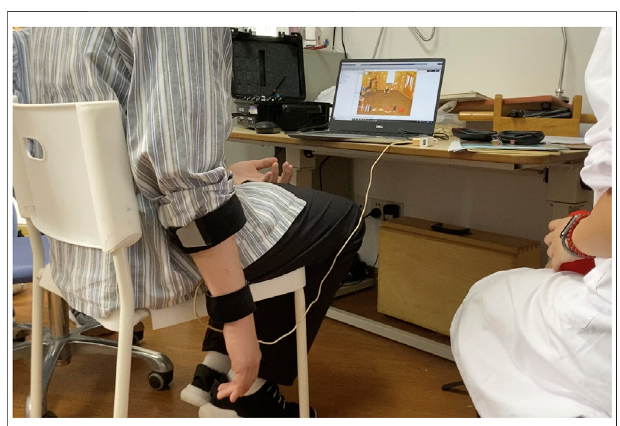
Frontiers in Physiology |